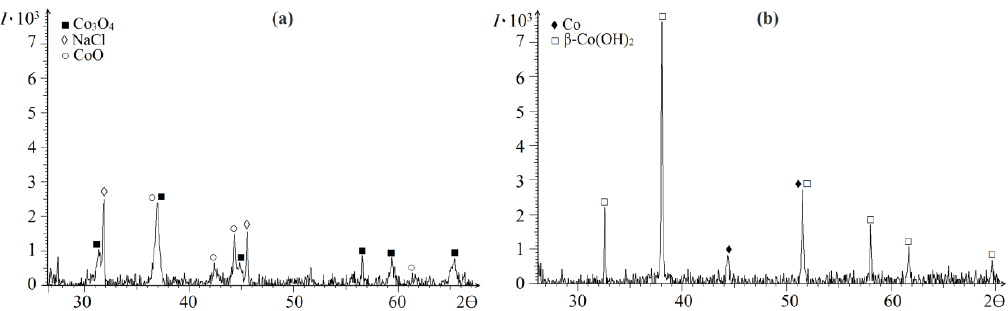
Figure 4. XRD patterns of AFP + Co(NO 3 ) 2 composites ( a ) after the HT at 700 ° С and ( b ) after APh electrohydrogenation.